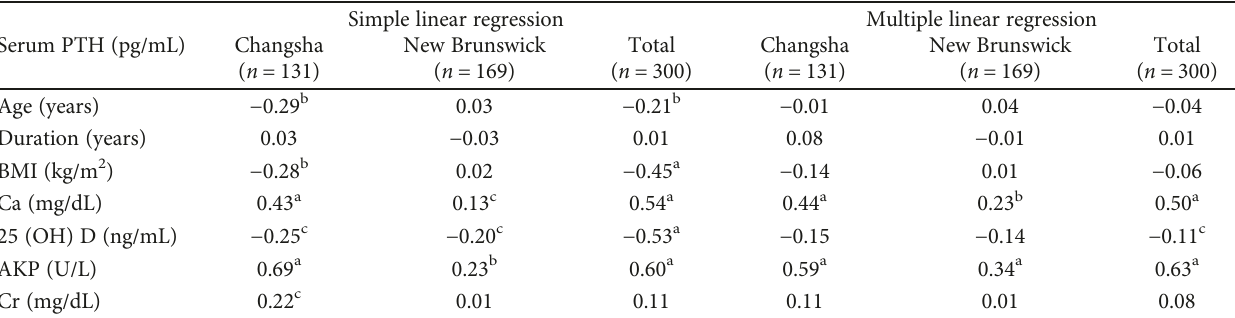
Table 4: Simple linear regression and multiple linear regression of relation adjusted for age and BMI (partial correlation coe ffi cients) between serum iPTH and other variables in patients with primary hyperparathyroidism in Changsha and New Brunswick and all patients in the two